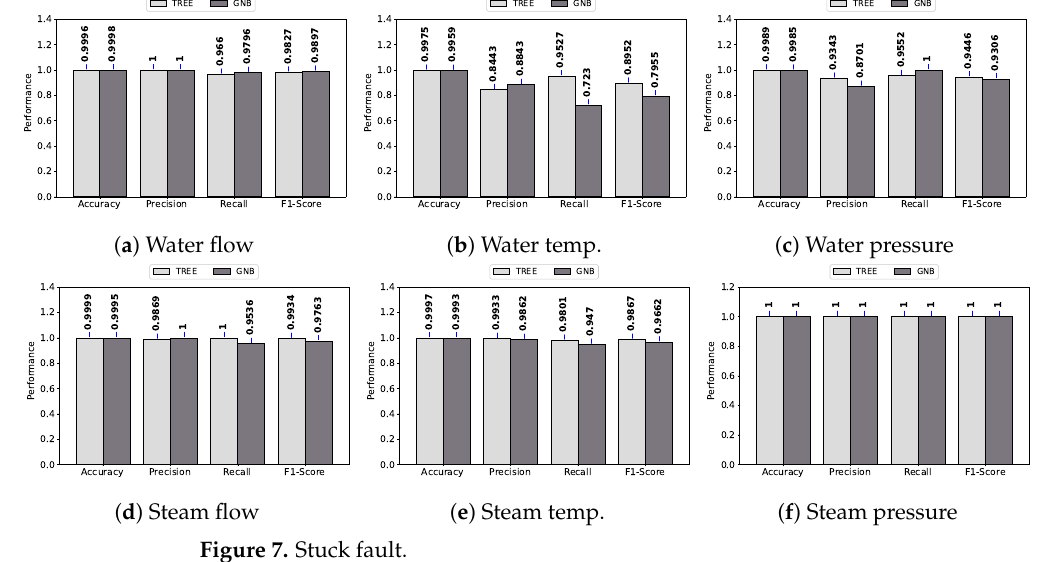
Figure 7. Stuck fault. Table 2. Delay (seconds) to communicate and detect the